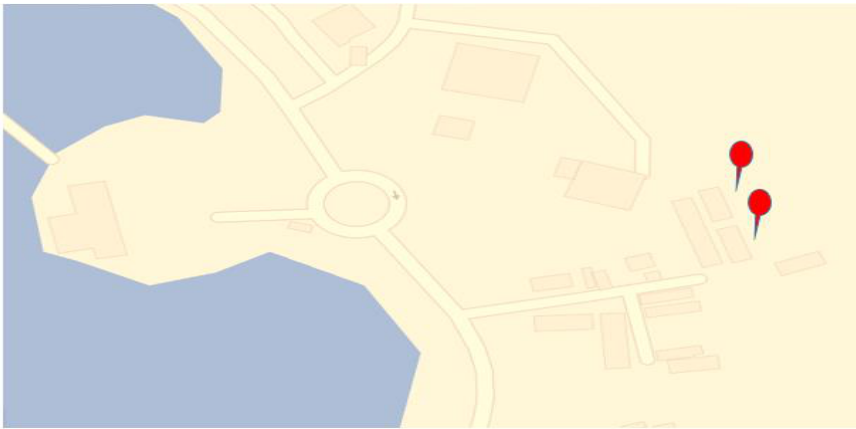
Figure 1. Greenhouses affiliated with the College of Agriculture and Forestry, Mosul University. https://goo.gl/maps/SuGqvhba4uQ3Tw6s5, accessed on 6 September 2021.